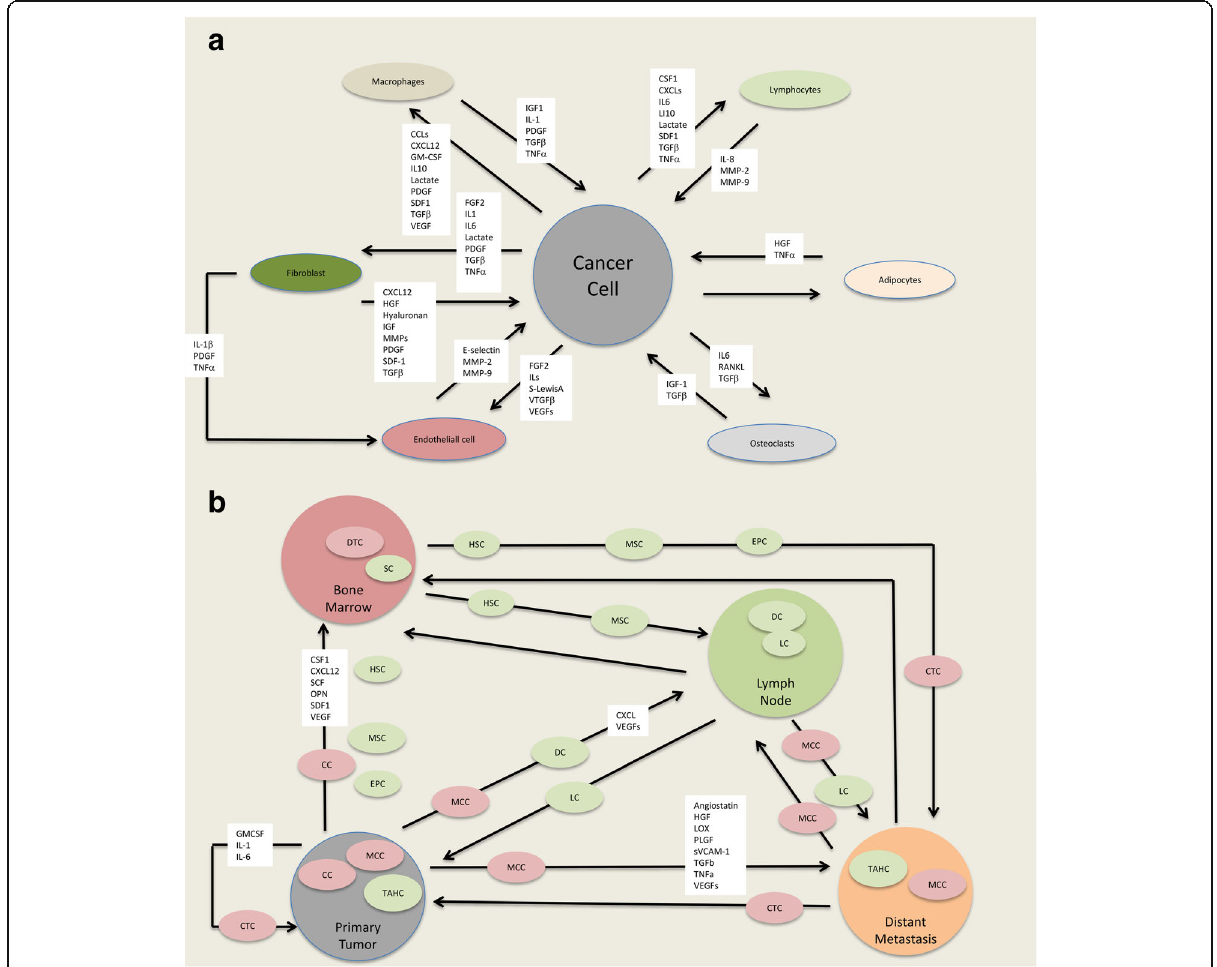
Fig. 2 Schematics of mutual communication between cancer cells, tumor associated host cells and ecosystems. a Schematic of communication between cancer cells and tumor-associated host cells with invasion-related radiation-sensitive molecules. Arrows indicate the communication between cancer cells and tumor-associated host cells, namely fibroblasts, macrophages, lymphocytes, adipocytes, osteoclasts and endothelial cells, and between tumor-associated host cells, for example fibroblasts to endothelial cells. White text boxes overlapping the arrows contain the molecules implicated in this communication and shown to be sensitive to alterations by radiation. This intercellular communication establishes the individual local ecosystems that participate at metastasis as shown in panel b Adapted from Mareel et al., (2009b), with data from: Vakaet (2004); Abdollahi (2005); Chargari et al., (2013); De Bacco et al., (2011b); Gu et al., (2015b); Hamalukic et al., (2011b); Hirschhaeuser et al., (2011); Kuonen et al., (2012a); Li et al., (2016b); Madani et al., (2008); Nubel (2004); Vilalta (2016); Lee et al., (2017c). b Schematic of the communication between ecosystems of primary tumor, distant metastasis, lymph node and bone marrow, associated with metastasis and sensitive to ionizing radiation. Arrows indicate the communication between ecosystems, namely the primary tumor, lymph node, distant metastasis and bone marrow. Participating at this communication are host cells (smaller green ovals), cancer cells (smaller pink ovals) and molecules (white text boxes), all implicated in radiation-enhanced metastasis. Adapted from: Madani et al., (2008); Ceelen et al., (2014) and Willaert et al., (2014) with data from: Kioi et al., (2010b); Kuonen et al., (2012c); Russell & Brown (2013b); Vilalta (2016). Abbreviations: CC, cancer cells; CCL, C-C motif chemokine ligand; CSF1, macrophage colony-stimulating factor 1; CTC, circulating tumor cells; CXCL, C-X-C motif chemokine ligand; DC, dendritic cells; DTC,disseminated tumor cells; EPC, endothelial precursor cells; FGF2, basic fibroblast growth factor; GMCSF, granulocyte-macrophage colony-stimulating factor; HGF, hepatocyte growth factor; HSC, hematopoietic stem cells; IGF1, insulin- like growth factor 1; IL, interleukin; LC, lymphocytes; MCC, metastatic cancer cells; MMP, matrix metalloproteinase; MSC, mesenchymal stem cells; OPN, osteoprotogerin; PDGF, platelet-derived growth factor; PlGF, placental growth factor; RANKL, receptor activator of nuclear kappa-B ligand; SC, stem cells; S-Lewis A, sialyl-Lewis A antigen; SCF, stem cell factor; SDF1 (also called CXCL12), stromal- cell derived factor 1; sVCAM1, soluble vascular cell adhesion molecule 1; TGF β , transforming growth factor beta; TNF α , tumor necrosis factor-alpha; VEGF, vascular endothelial growth